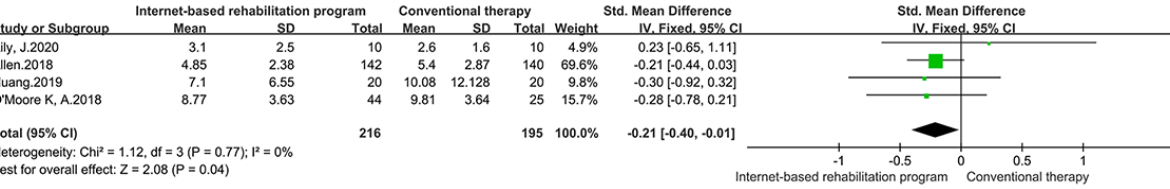
Figure 2. Forest plot of included studies comparing the effect of the internet-based intervention and conventional rehabilitation on pain according to the Western Ontario and McMaster Universities Osteoarthritis (WOMAC) pain subscale.